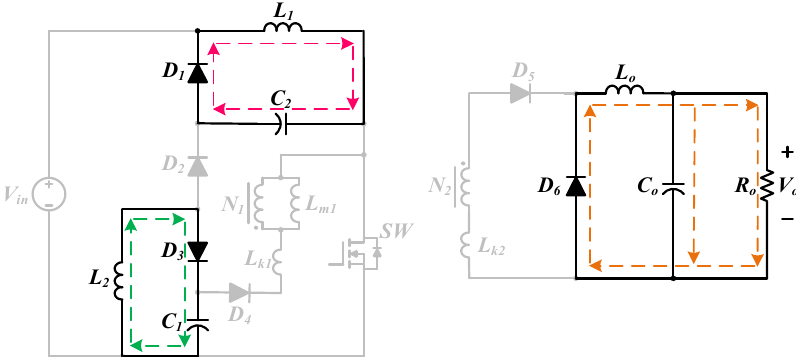
Figure 9. Equivalent circuit of the CHSDC in Mode 4.